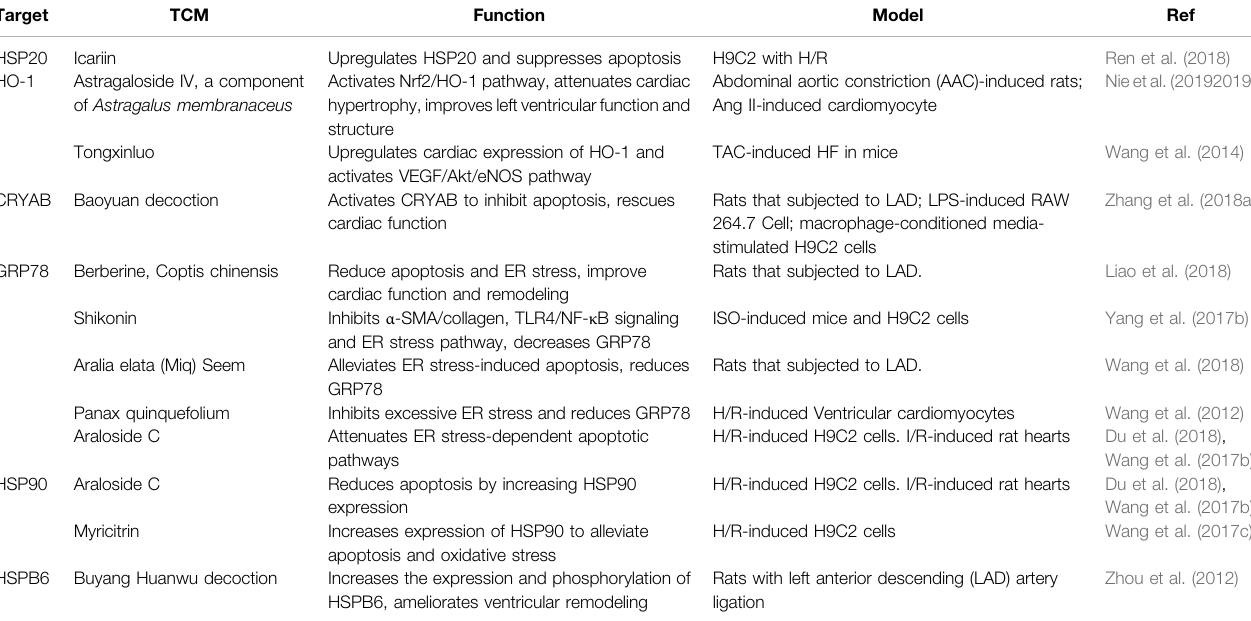
TABLE 3 | Traditional Chinese Medicine that target heat shock proteins in myocardial